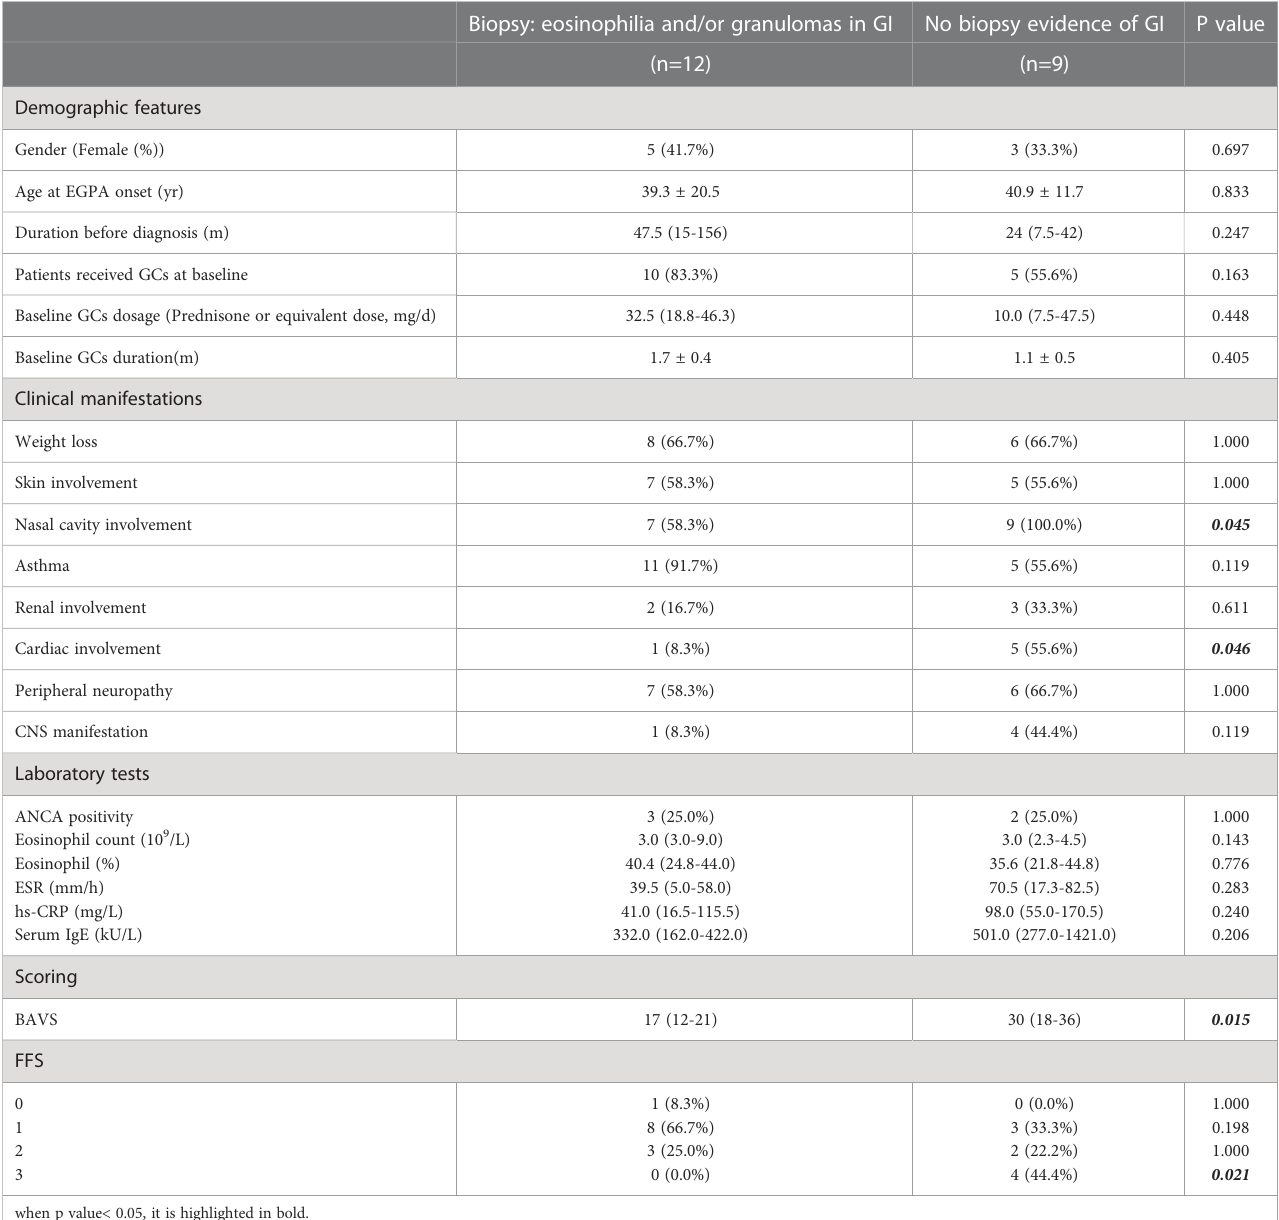
TABLE 2 Characteristics of EGPA patients with GI involvement